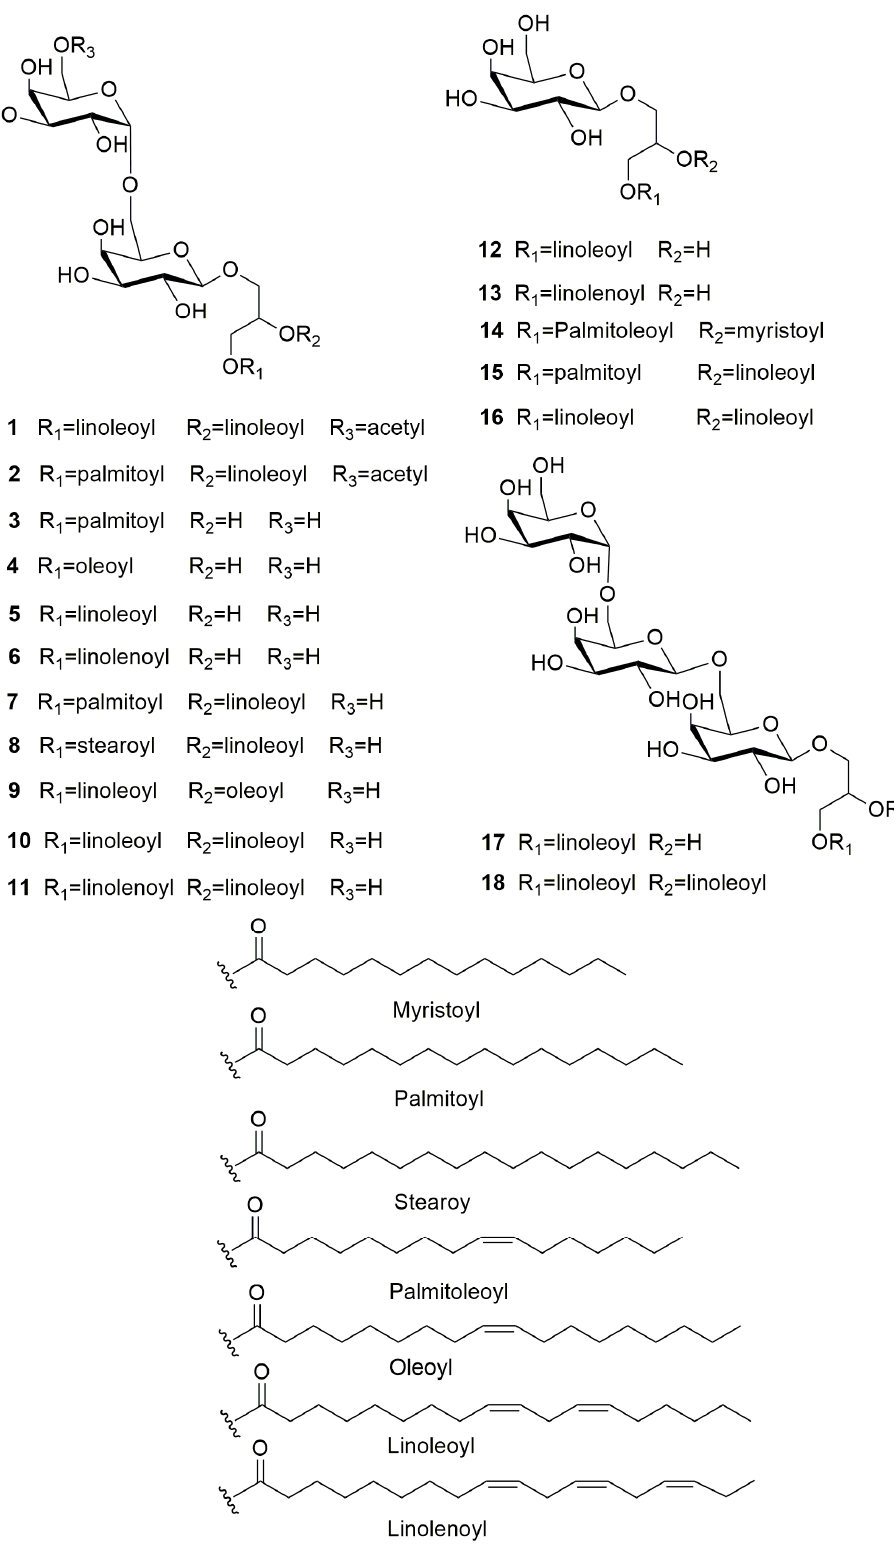
Figure 4. Chemical structures of compounds 1 – 18 from Tubeufia rubra PF02-2.